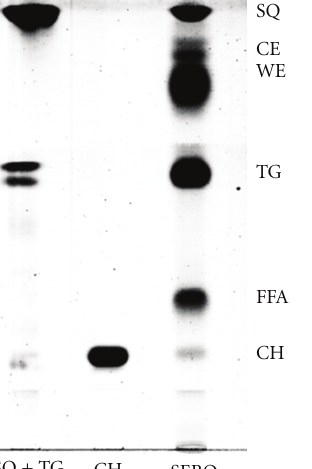
Figure 1: Thin Layer Chromatography of forehead sebum. Triglyc- erides (TG); Free fatty acids (FFA); Wax esters (WE); Squalene (SQ); Cholesterol esters (CE); Cholesterol (CH).